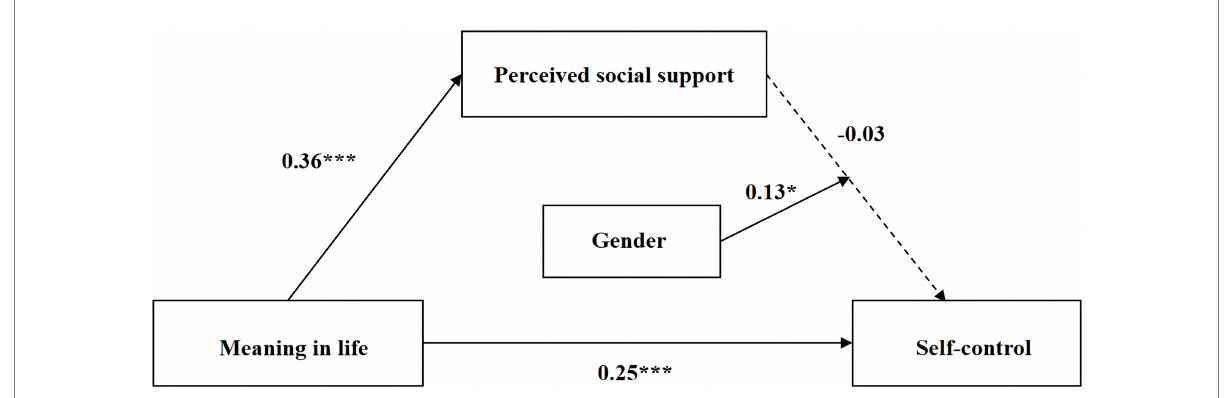
FIGURE 3 A moderated mediation model of the gender. *The correlation is significant at the 0.05 level. ***The correlation is significant at the 0.01